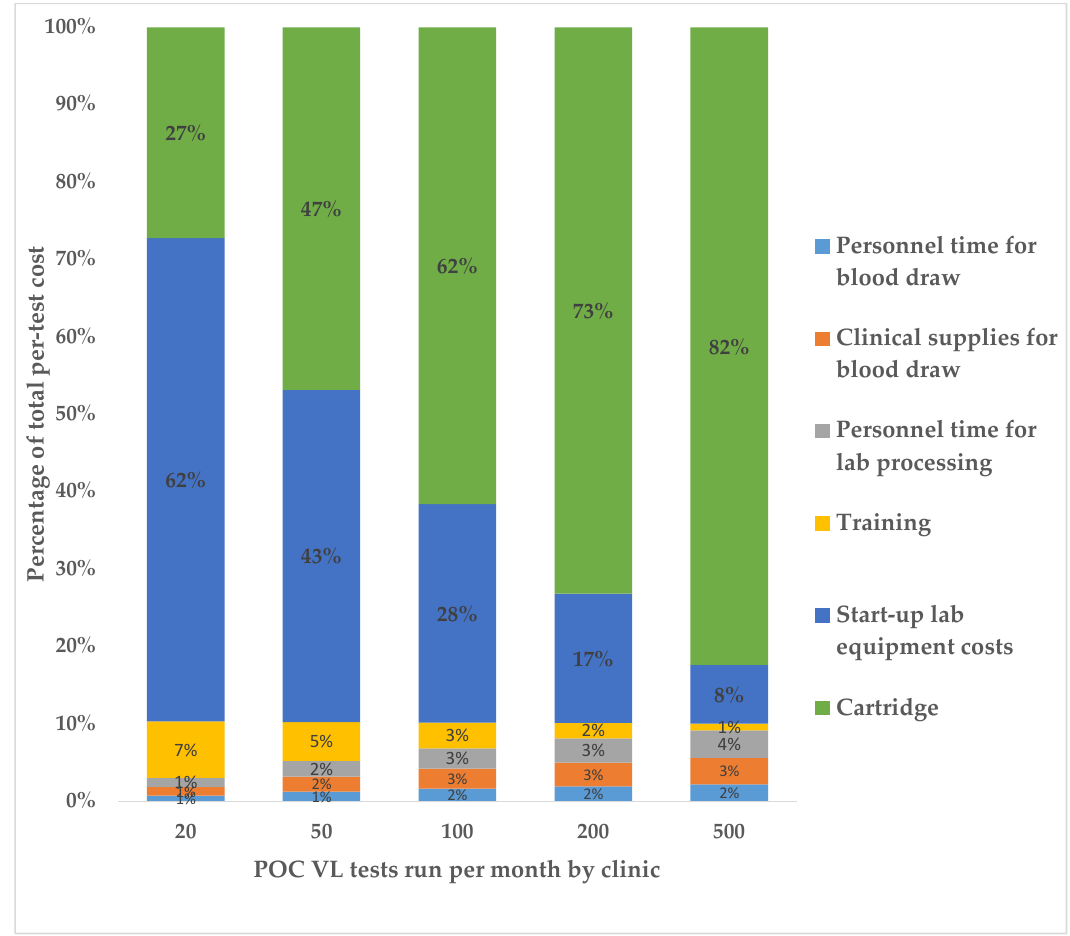
Figure 2. Percentage breakdown of total POC VL per-test costs per category, for varying clinic testing volumes (2020 USD). Table 3. Equipment costs for POC VL testing (2020 USD).